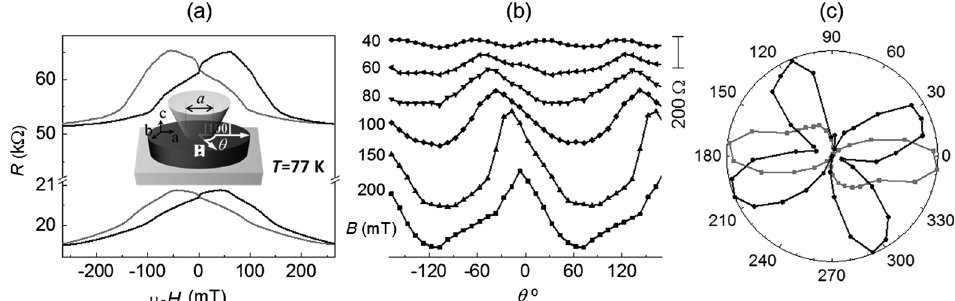
FIG. 1. (a) Point-contact magnetoresistance (MR) for two point contacts of different size: PC1 with a ≈ 3 μ m (bottom) and PC2 with 1 μ m (top). The black (gray) traces show the up (down) MR sweeps. The insert shows a schematic of our experiment: a point contact of size a between a sharpened Cu tip (top gray) and the Sr 2 IrO 4 crystal (dark) is used to inject an electrical current into the crystal; flowing primarily along the [001] c axis into a Cu back electrode (bottom gray); magnetic field is applied in the a - b plane at an angle θ between the field and the [100] a axis. (b) Angular dependence R ð θ Þ of PC1 contact resistance for different magnetic fields (from top to bottom μ H ¼ 40 , 60, 80, 100, 150, 200 mT). (c) Polar plots of the normalized AMR at μ 0 measurements are done at T ¼ 77